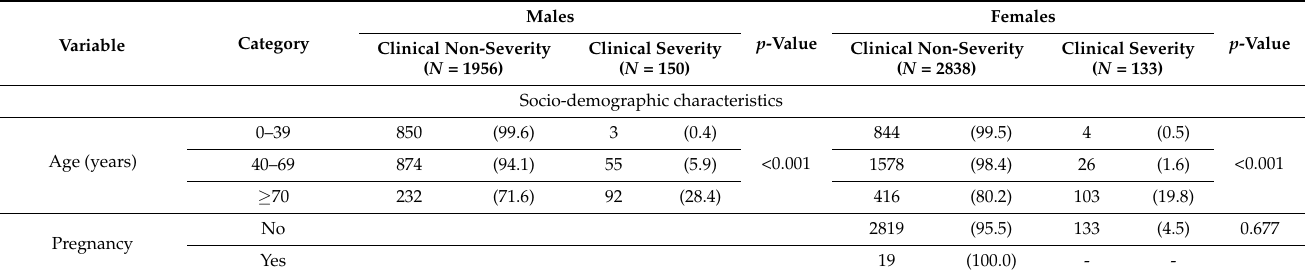
Table 2. Differences in the clinical severity for each sample characteristic by